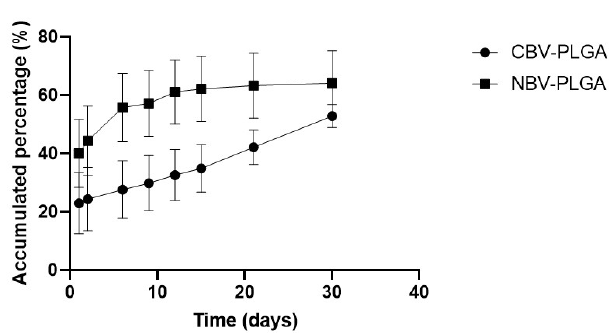
FIGURE 4 - In vitro release test of CBV-PLGA (circle) and NBV-PLGA (squares) implants in PBS, pH 7.4, 37ºC. Each studied group had six implants evaluated. Statistical difference was found between the two groups (p <